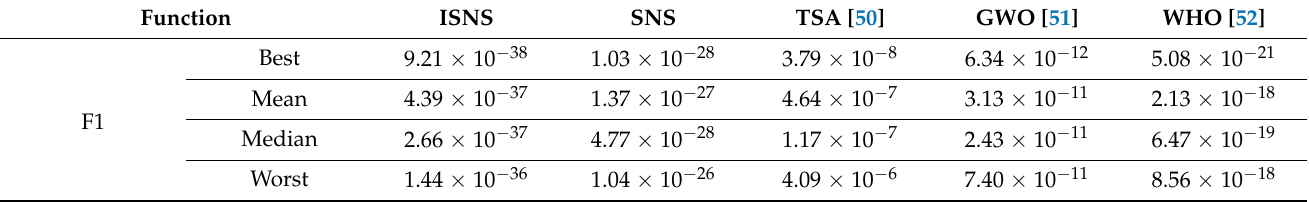
Figure 10. Qualitative metrics of nine benchmark functions: 2D views of the functions, search history, average fitness history, and convergence curve using ISNS algorithm. Table 1. The statistical results of benchmark functions using the proposed ISNS technique and other recent techniques.